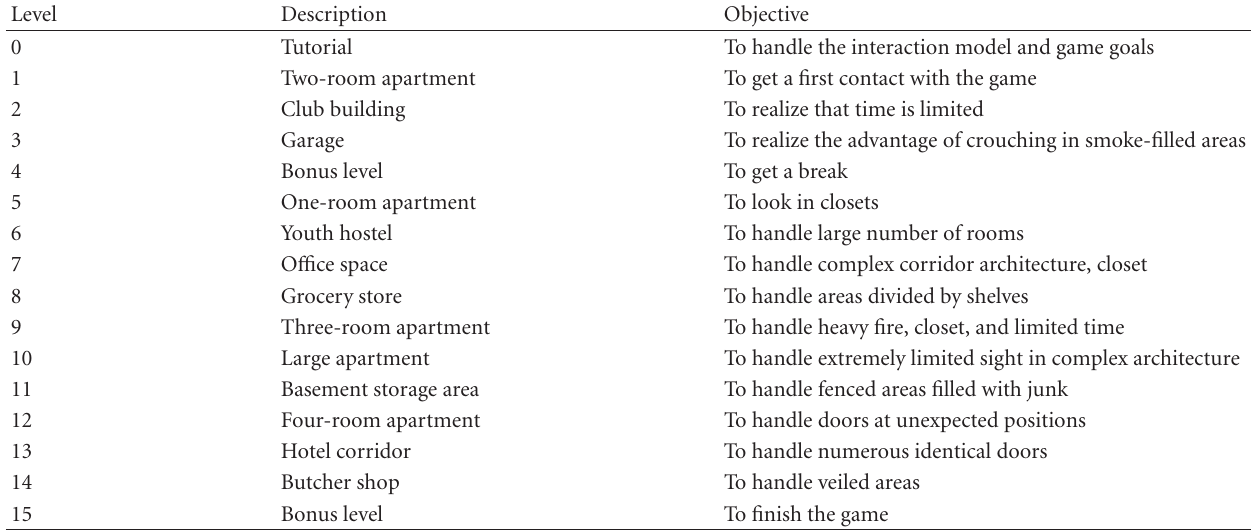
Table 1: Game levels and their learning